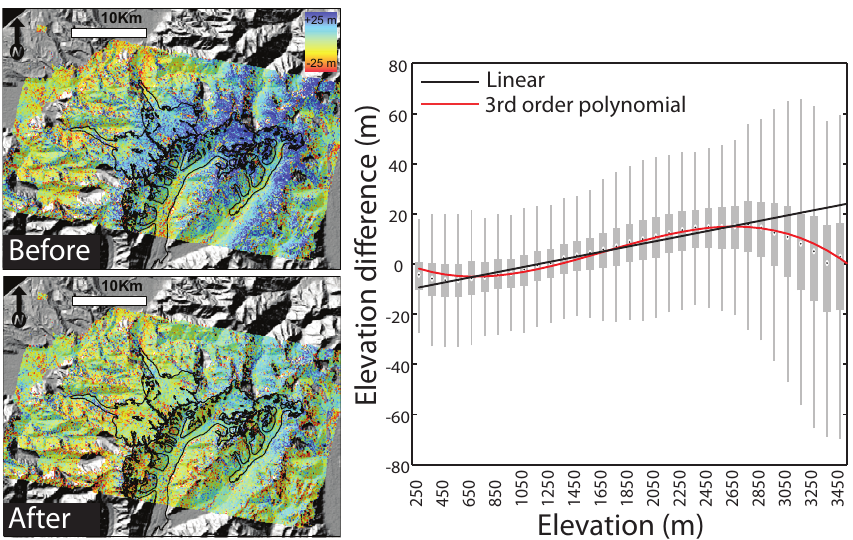
Fig. 3. Example of elevation differences between 2003 and 2002 ASTER DEMs from Sect. 5.2 before and after applying an elevation dependent bias correction using a 3rd order polynomial. The two DEMs were first co-registered before checking for an elevation dependent bias. Glacier masks are indicated by black